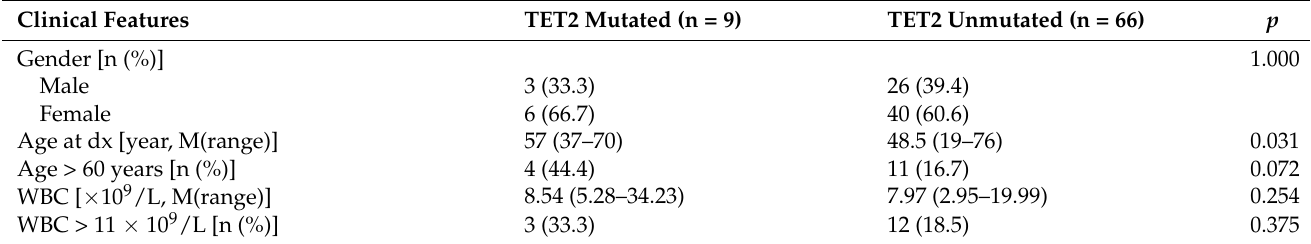
Table 5. Clinical features and coagulation function of TET2-mutated and -unmutated ET